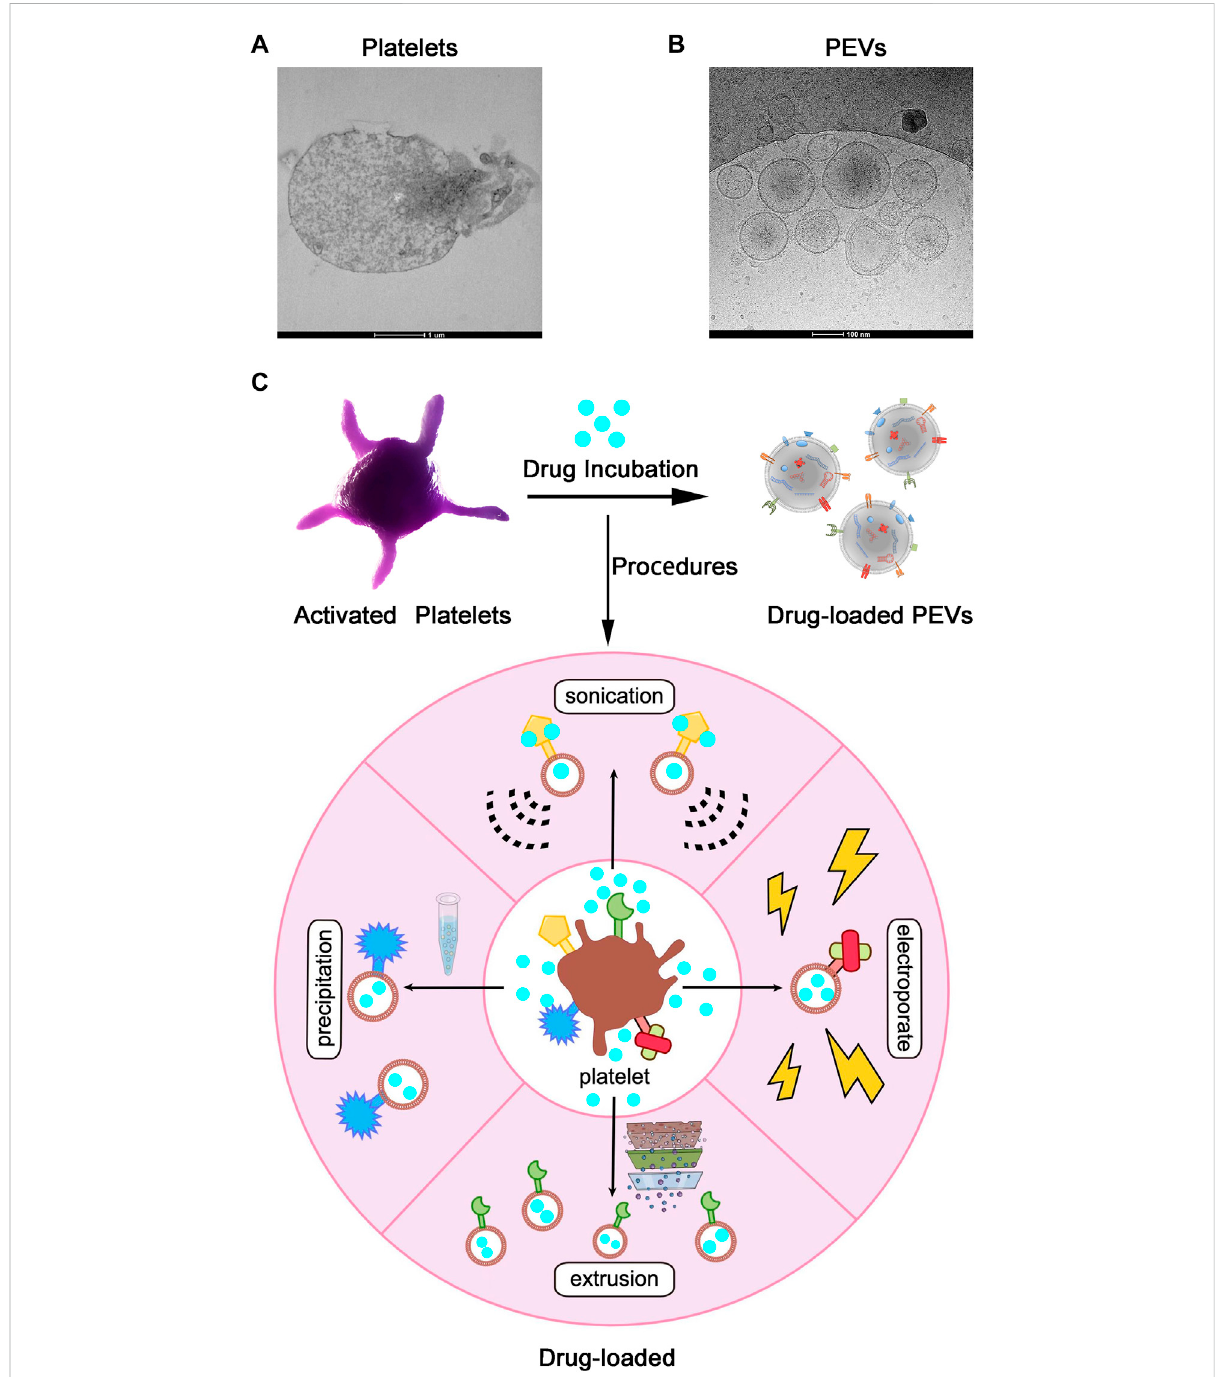
FIGURE 3 ApplicationofPlateletExtracellular Vesicles(PEVs)asDrug-LoadedDeliverySystems. (A) TransmissionelectronmicroscopeimagesofPlatelets and (B) PEVs. Scale bar = 1 µm, 100 nm. (C) After activation or other processes, platelets shed PEVs, which inherit membrane properties from the parental platelets. PEVs can be loaded with drugs by the application of various procedures (such as precipitation, sonication, extrusion, electroporation, and so on) and used as targeted drug delivery